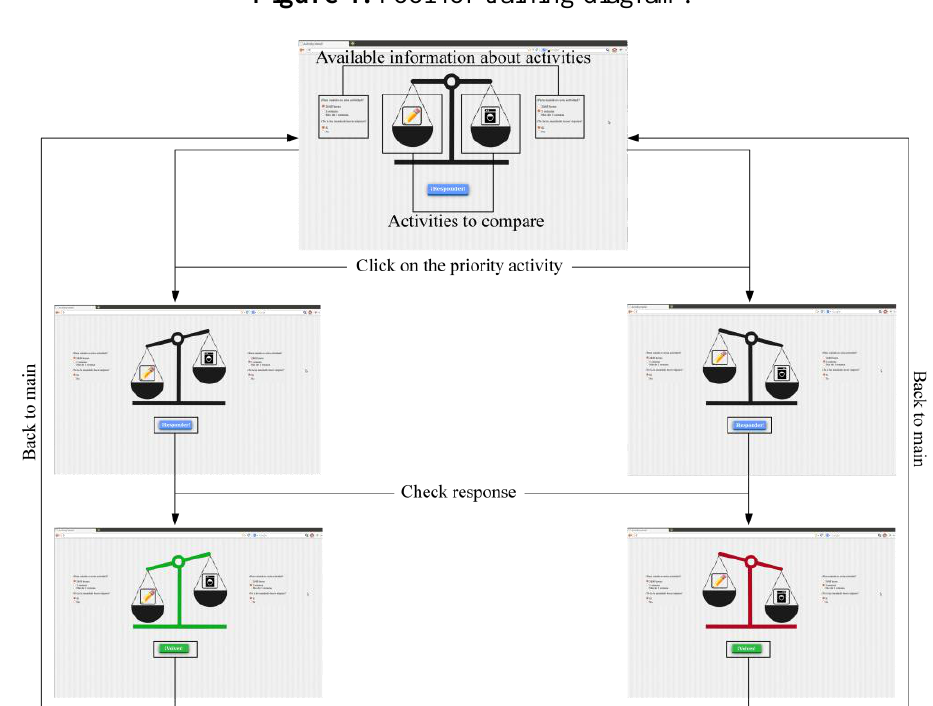
Figure 4. Tool for training